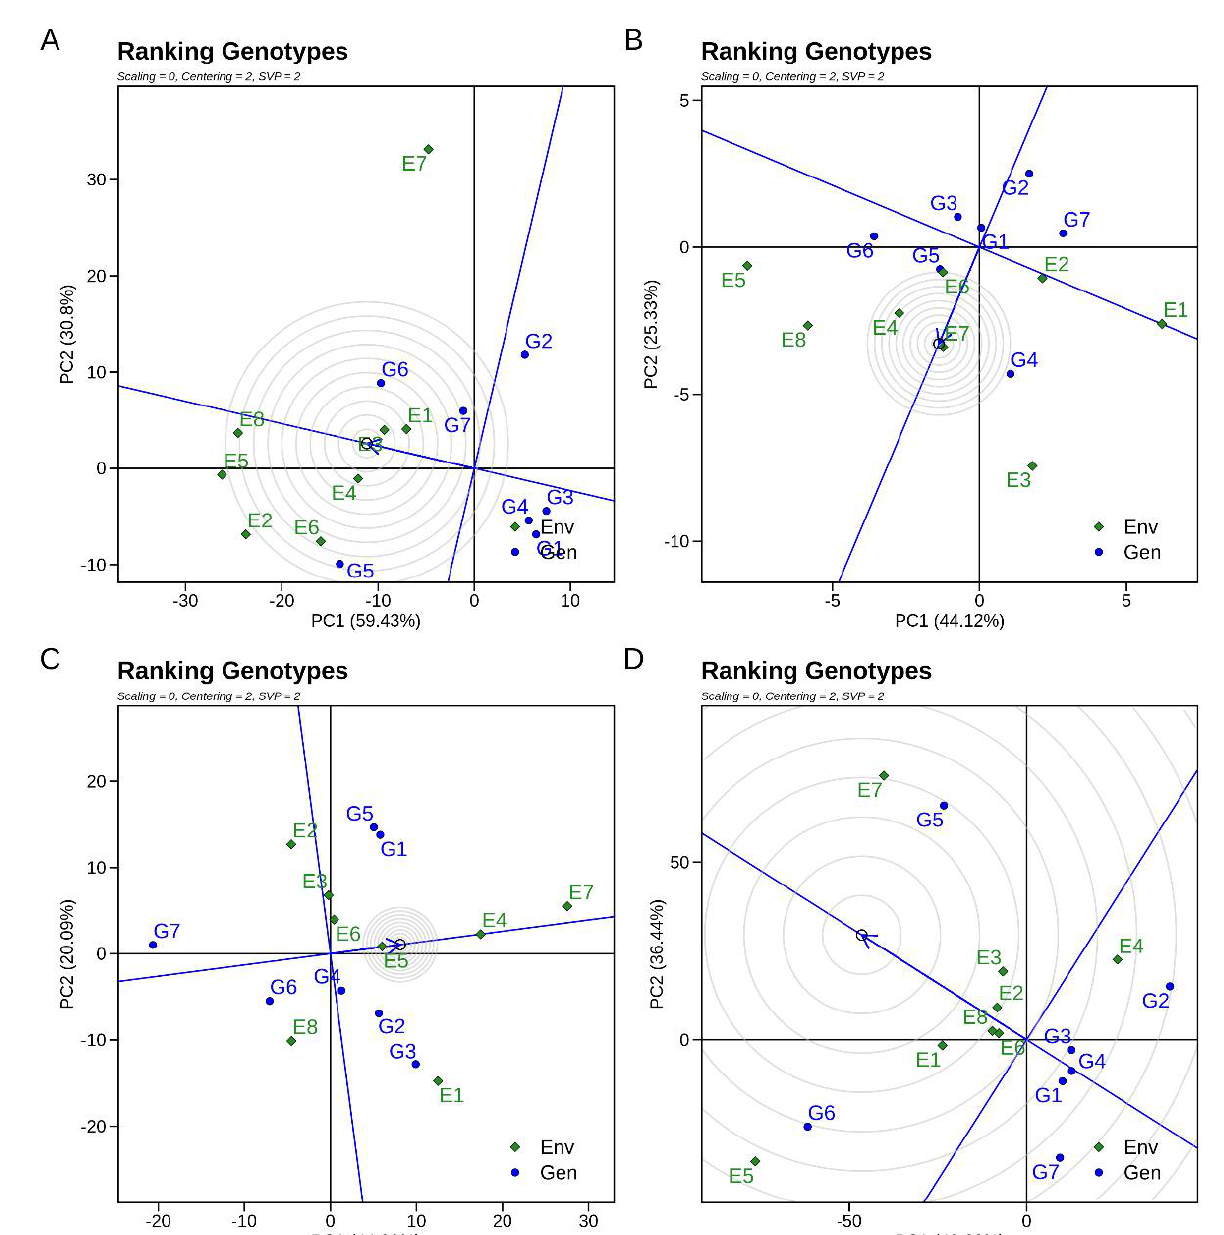
Figure 8. The GGE biplot ‘Ranking genotypes’ pattern to rank genotypes for the ideal genotype of 5 GSR lines and 2 control lines grown under eight environments in the year 2021 for ( A ) plant height, ( B ) the number of tillers, ( C ) grain yield, and ( D ) straw yield. The biplots were created with centering = 0, SVP = 2, and scaling = 0 parameters.